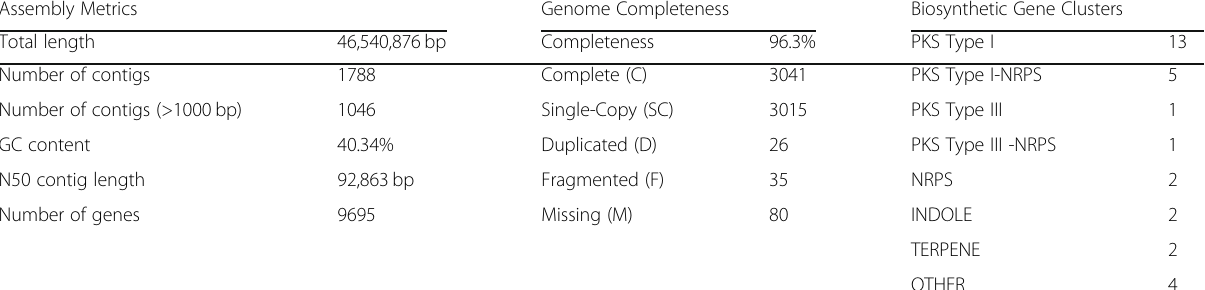
Table 2 Assembly metric, genome completeness and number of biosynthetic gene clusters (BGC) of Alectoria sarmentosa binned